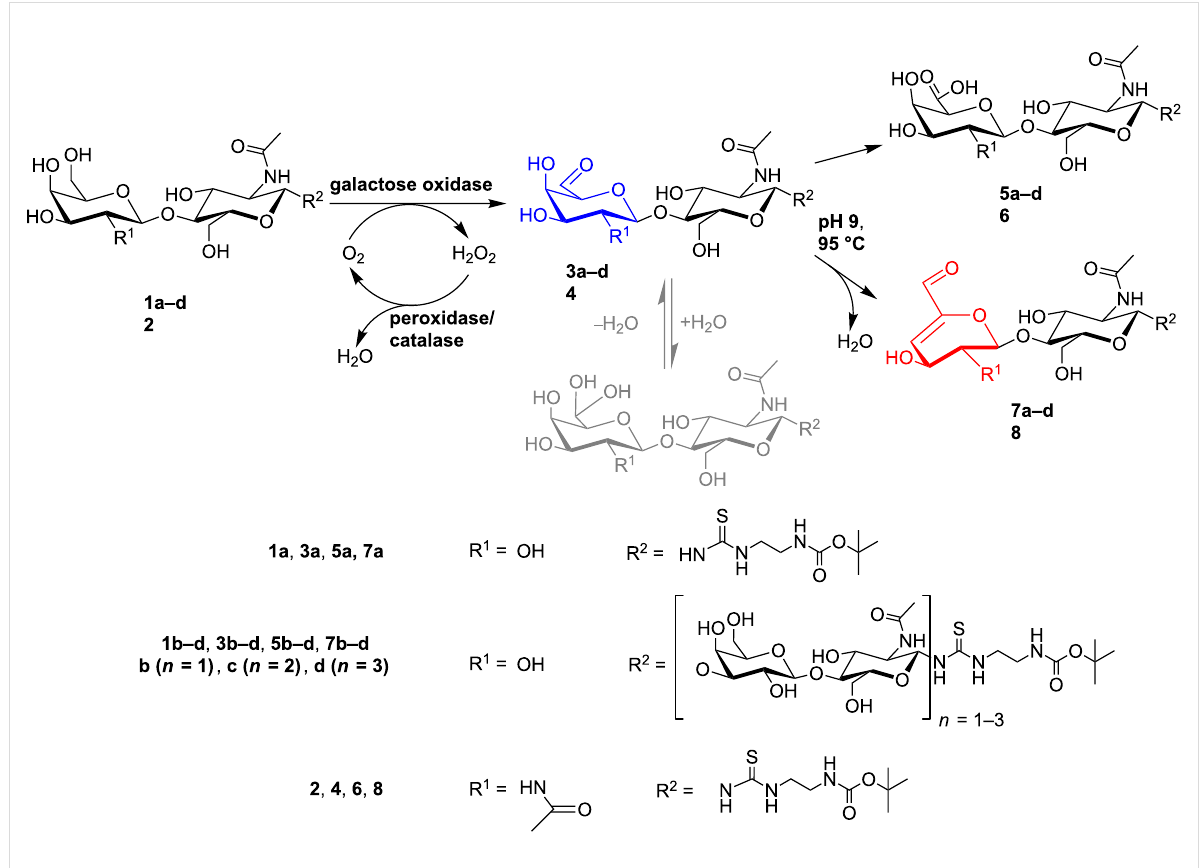
Scheme 1: Reaction scheme of terminal galactose in poly-LacNAc-glycans ( 1a – d ) or GalNAc in LacDiNAc ( 2 ) by galactose oxidase, to the corres- ponding 6-aldehyde ( 3a – d , 4 ). Subsequent further oxidation yields the corresponding galacturonic acids ( 5a – d , 6 ), and chemical β -elimination the corresponding α , β -unsaturated aldehydes ( 7a – d , 8